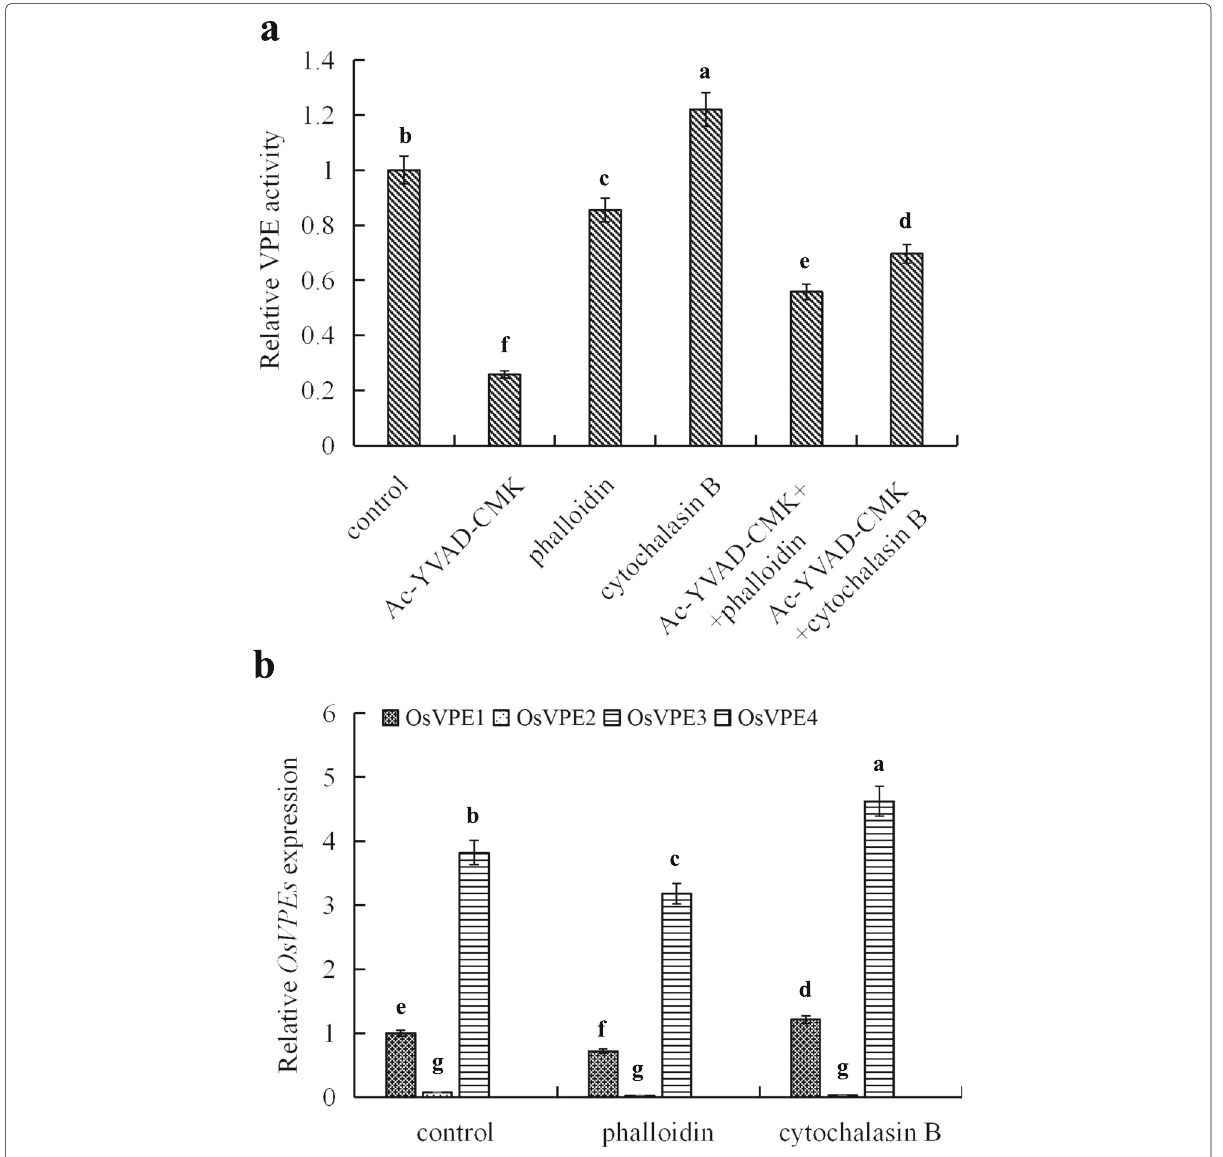
Fig. 4 The depolymerization of AF increased the levels of OsVPE3 mRNA transcription and VPE activity. Aleurone layers were stripped from the intact seeds imbibed for 12 h, and then the isolated layers were pre-incubated in a solution containing distilled water alone (control) or 10 μ g/mL phalloidin (AF depolymerization inhibitor), 10 μ g/mL cytochalasin B (CB) (AF depolymerizer), 10 μ M Ac-YVAD-CMK (caspase-1 inhibitor) alone or in combination for 12 h. VPE activities ( a ) and OsVPE1-4 mRNA transcripts ( b ) were measured. The VPE activity and OsVPE1 expression in the control were selected as 1. Error bars represent the means ± s.d., n = 3 biological independent experiments with at least three replicates for each. Bars with different alphabets show significant different at P < 0.05 by Duncan’s multiple range